Question: In a single sentence, describe what this figure presents.
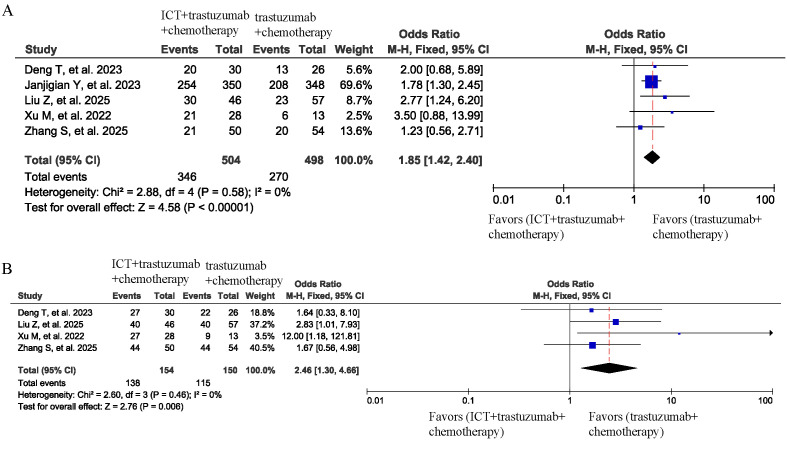
Answer: Forest plots of odds ratios (HR) with 95% confidence intervals (CI) for (A) Objective Response Rate and (B) Disease Control Rate in patients with HER2-positive gastric or gastro-oesophageal adenocarcinoma.